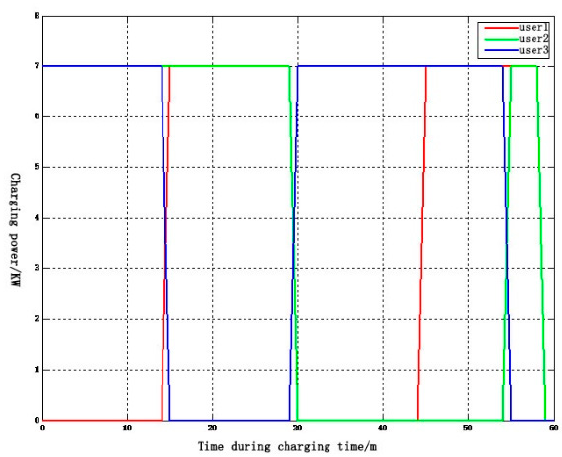
Information 2020 , 11 , x FOR PEER REVIEW Figure 4. Charging time allocation results from 19:00 to 20:00 h. Figure 4. Charging time allocation results from 19:00 to 20:00 hours.